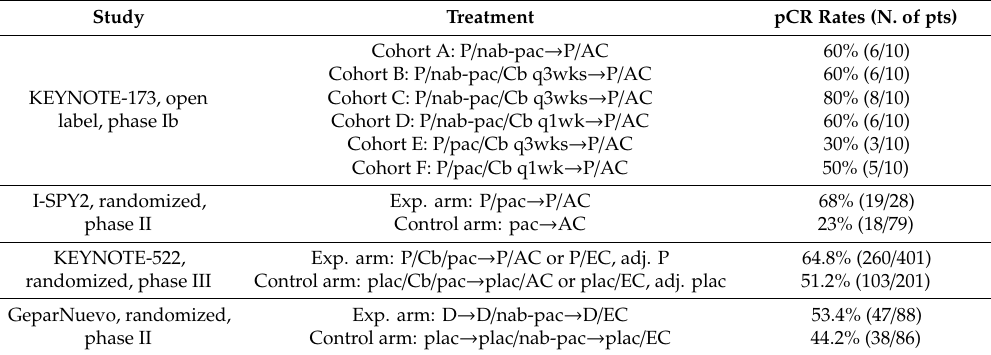
Table 1. Main characteristics and pathologic complete response (pCR) rates of clinical trials with ICIs in early-stage